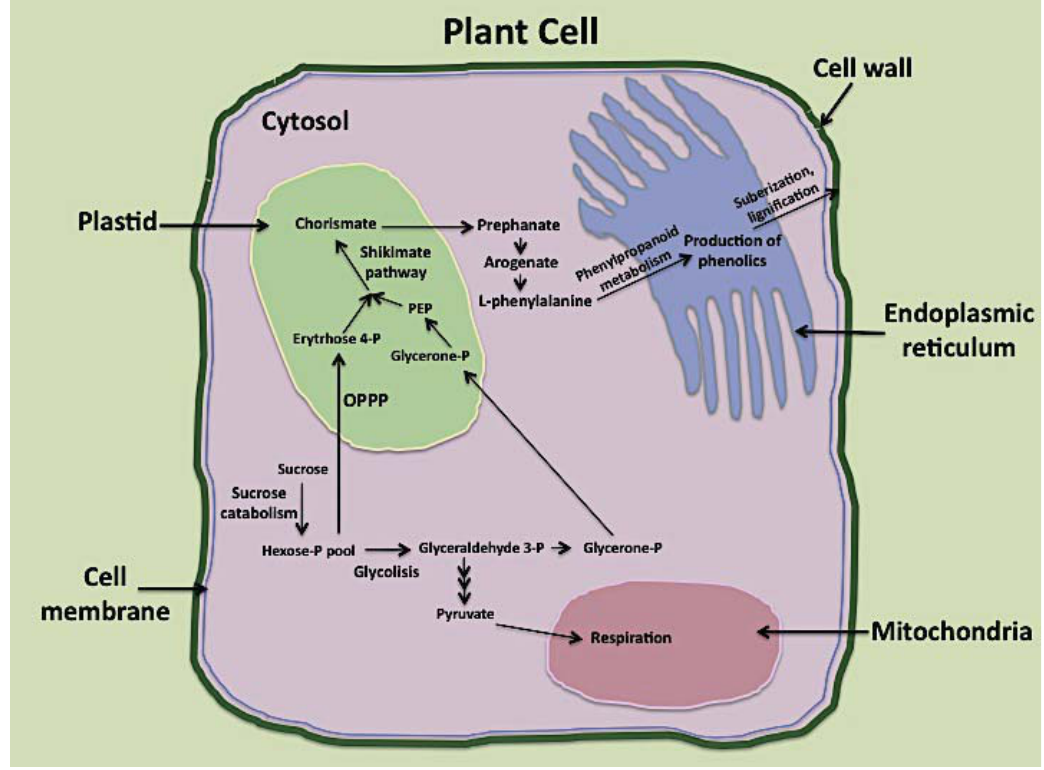
Figure 2. Plant metabolic mechanism used for the biosynthesis of